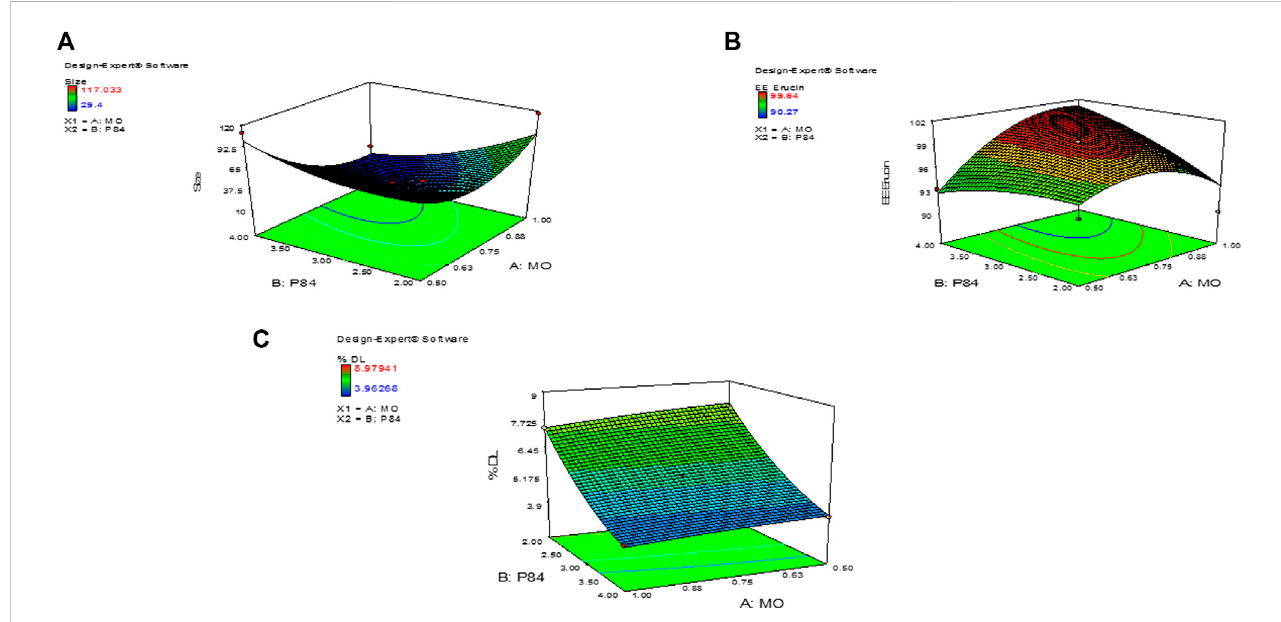
FIGURE 3 3D images of Central composite design of experiment showing (A) Size of ER-CUB (B) Entrapment ef fi ciency (C) Drug loading of ER.